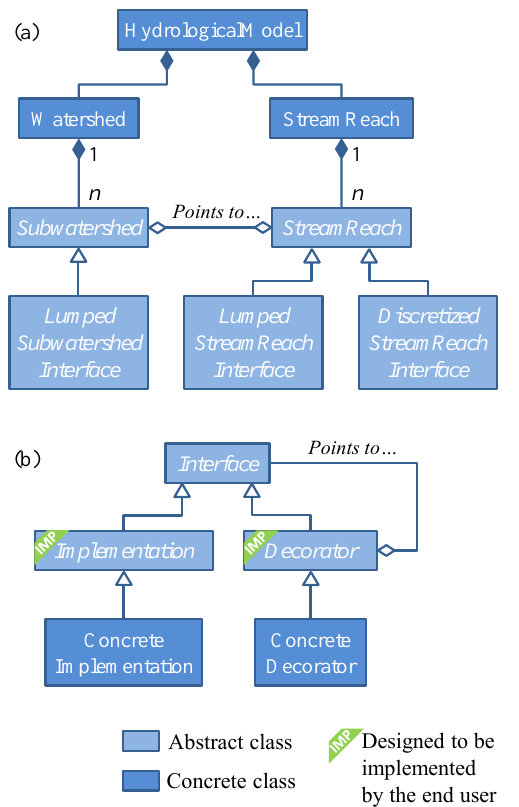
Figure 3. Structure of StreamFlow’s source code. (a) Simplified di- agram of StreamFlow’s high-level classes; (b) diagram of the Deco- rator pattern used to implement abstract classes “LumpedSubwater- shedInterface”, “LumpedStreamReachInterface” and “Discretized-